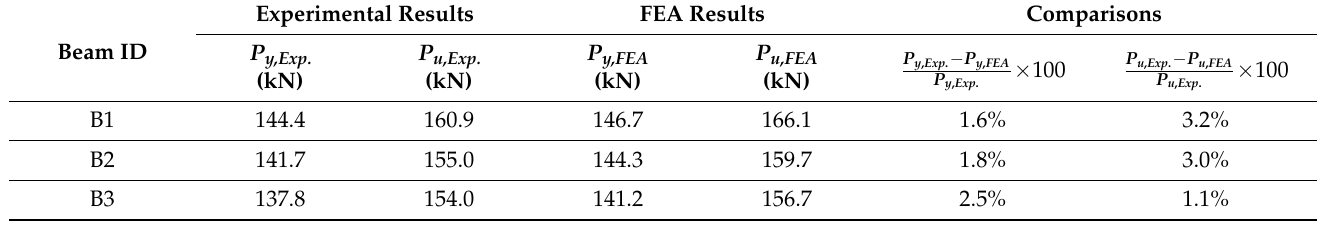
Table 4. Comparison between the experimental and FEA results of the tested RC beams. Experimental Results FEA Results Comparisons Beam ID